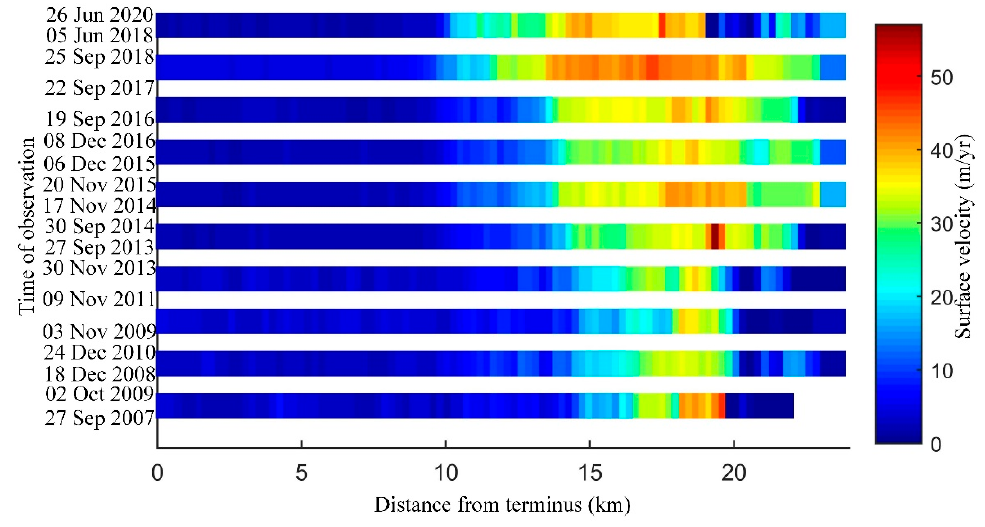
Figure 10. Evolution of surface velocity along with the longitudinal profile (see Figure 1) from 2007 to